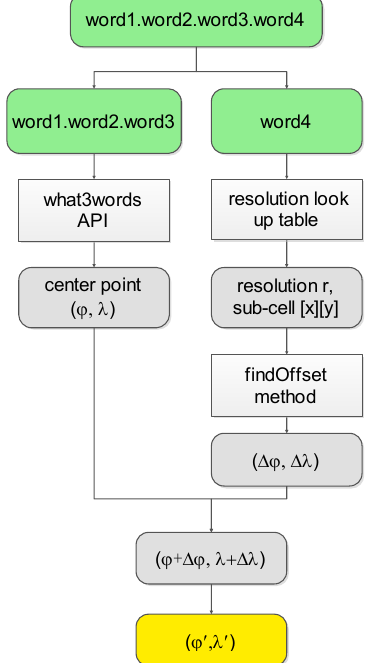
Figure 4. Work flow of extended forwarding geocoding with four-word